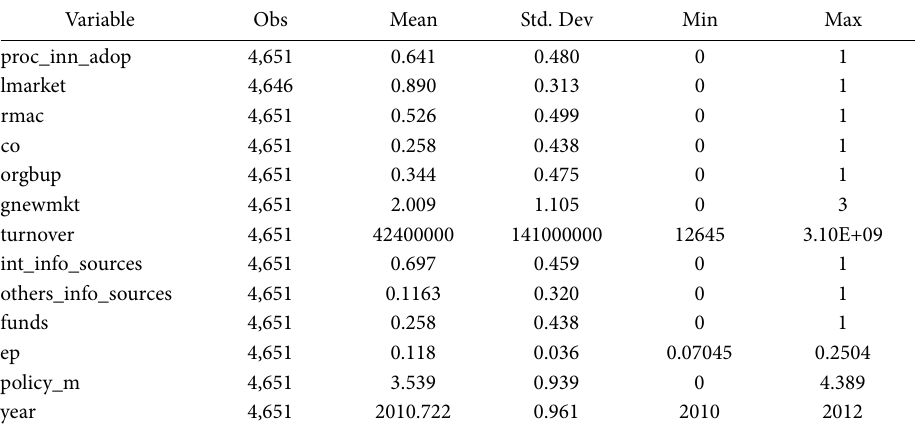
Table A. 2. Descriptive statistics of the Panel